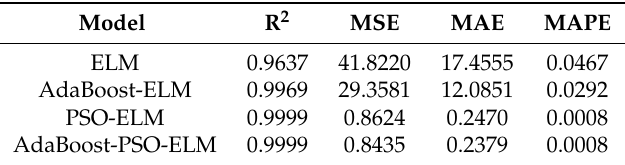
Table 2. The calculation results of the four Table2. The calculation results of the four models.